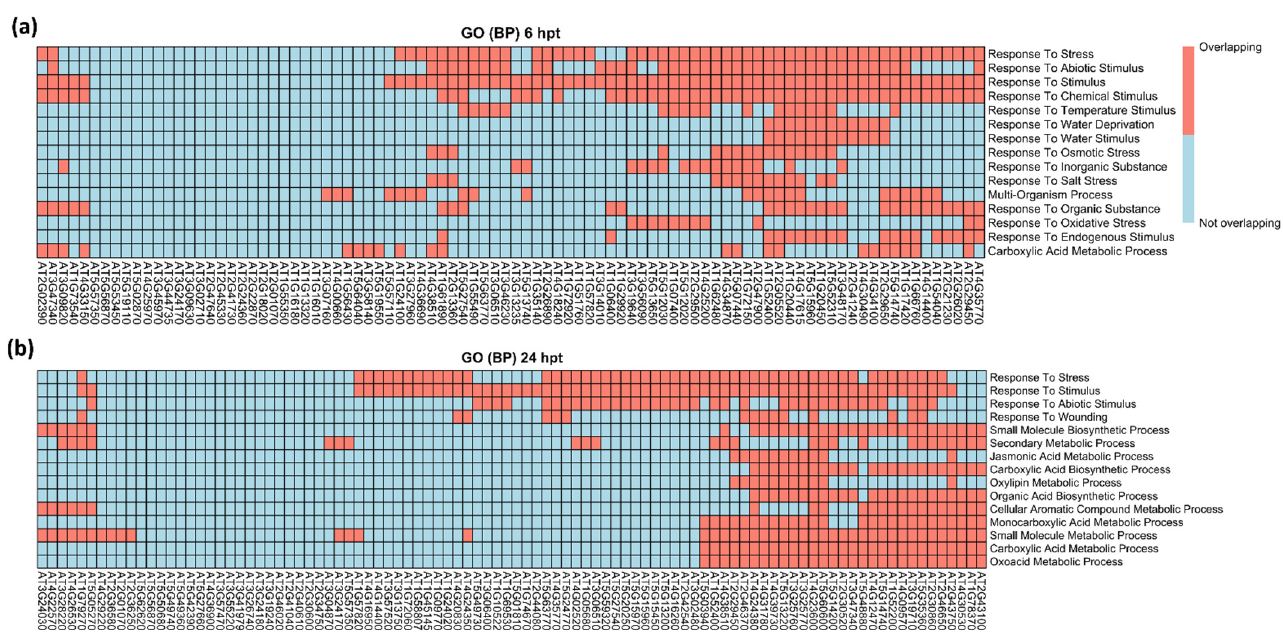
Figure 2. Heatmap of the differentially expressed genes encoding the top 15 significant GO terms. ( a ) Significant BP terms at 6 hpt. ( b ) Significant BP terms at 24 hpt. Overlapping genes were orange and not overlapping genes were light blue. Schemes follow the same formatting.